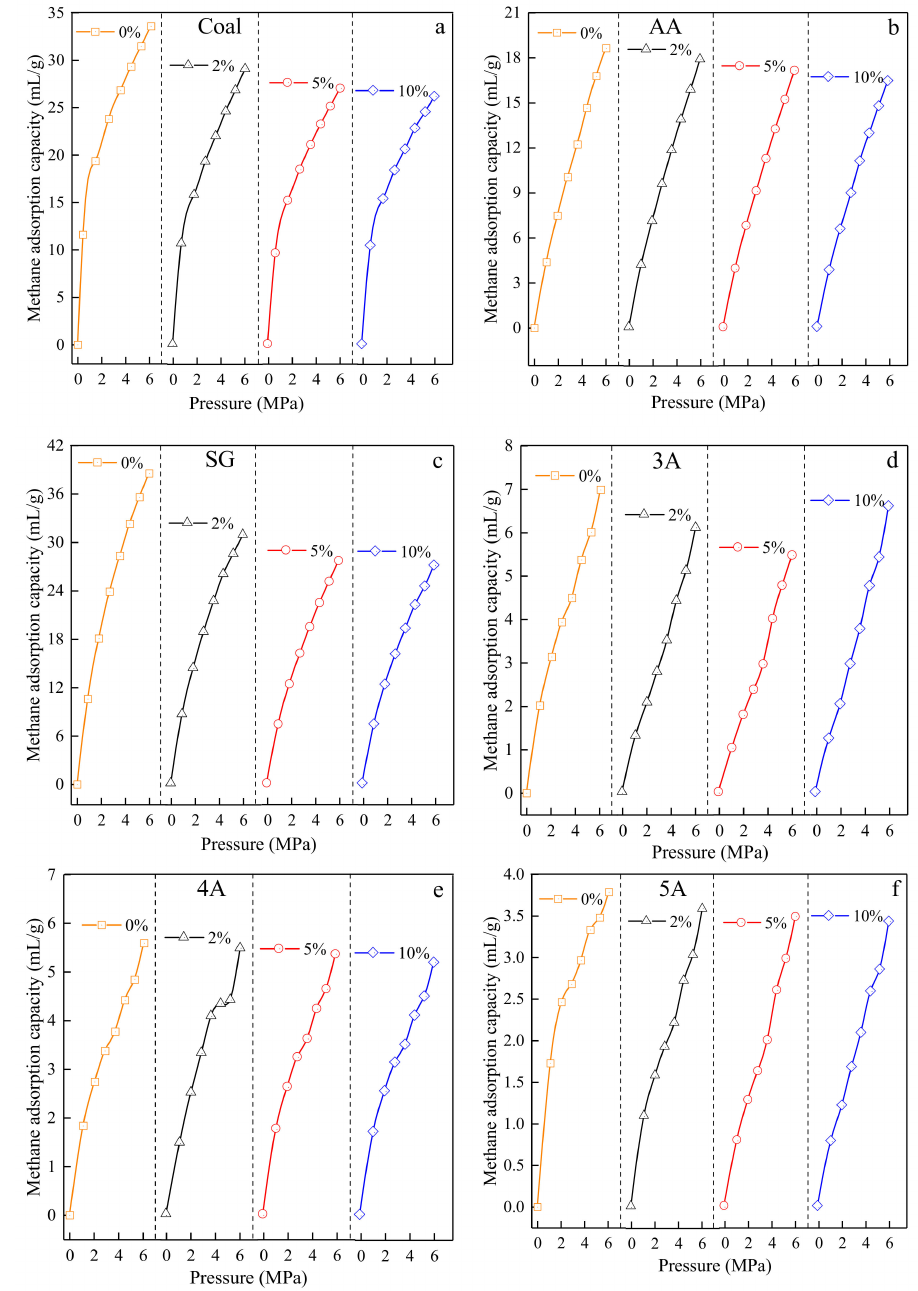
Figure 7. Adsorption isotherms of testing materials in di ff erent moisture: ( a ) Aiweiergou 1890# working face coal sample; ( b ) Activated alumina; ( c ) Silica gel; ( d ) 3Å molecular sieve; ( e ) 4Å molecular sieve; ( f ) 5Å molecular